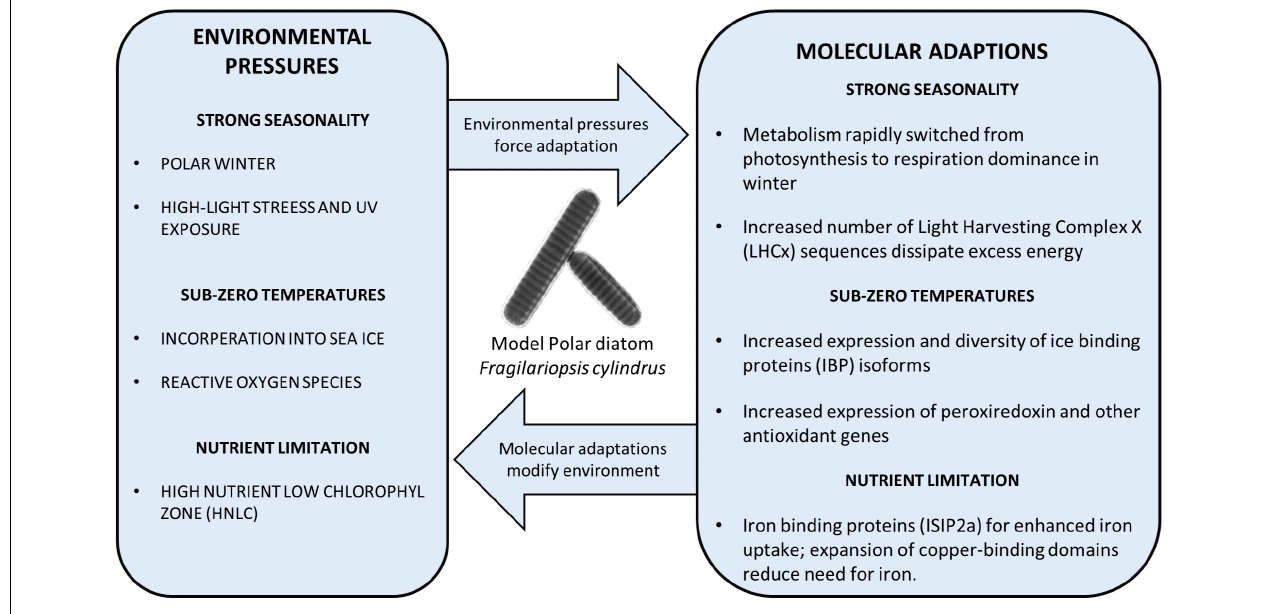
FIGURE 1 | Diagram showing examples of the adaptations of polar diatoms to a variety of polar environmental stressors, discovered using the model diatom F. cylindrus . Directional arrows display the pressure from the environment and the feedback/modification of the environment by polar